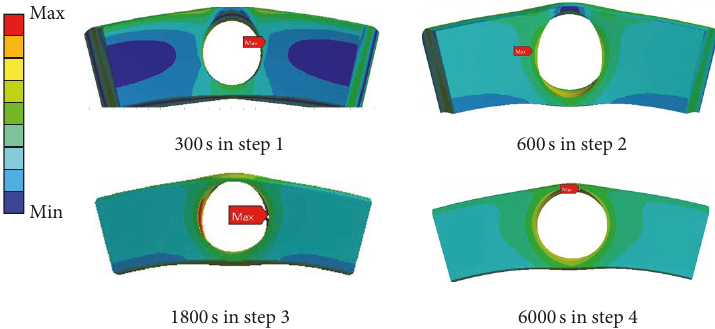
Figure 16: The variation of the maximum equivalent stress location of the rear shaft hole during the start-up